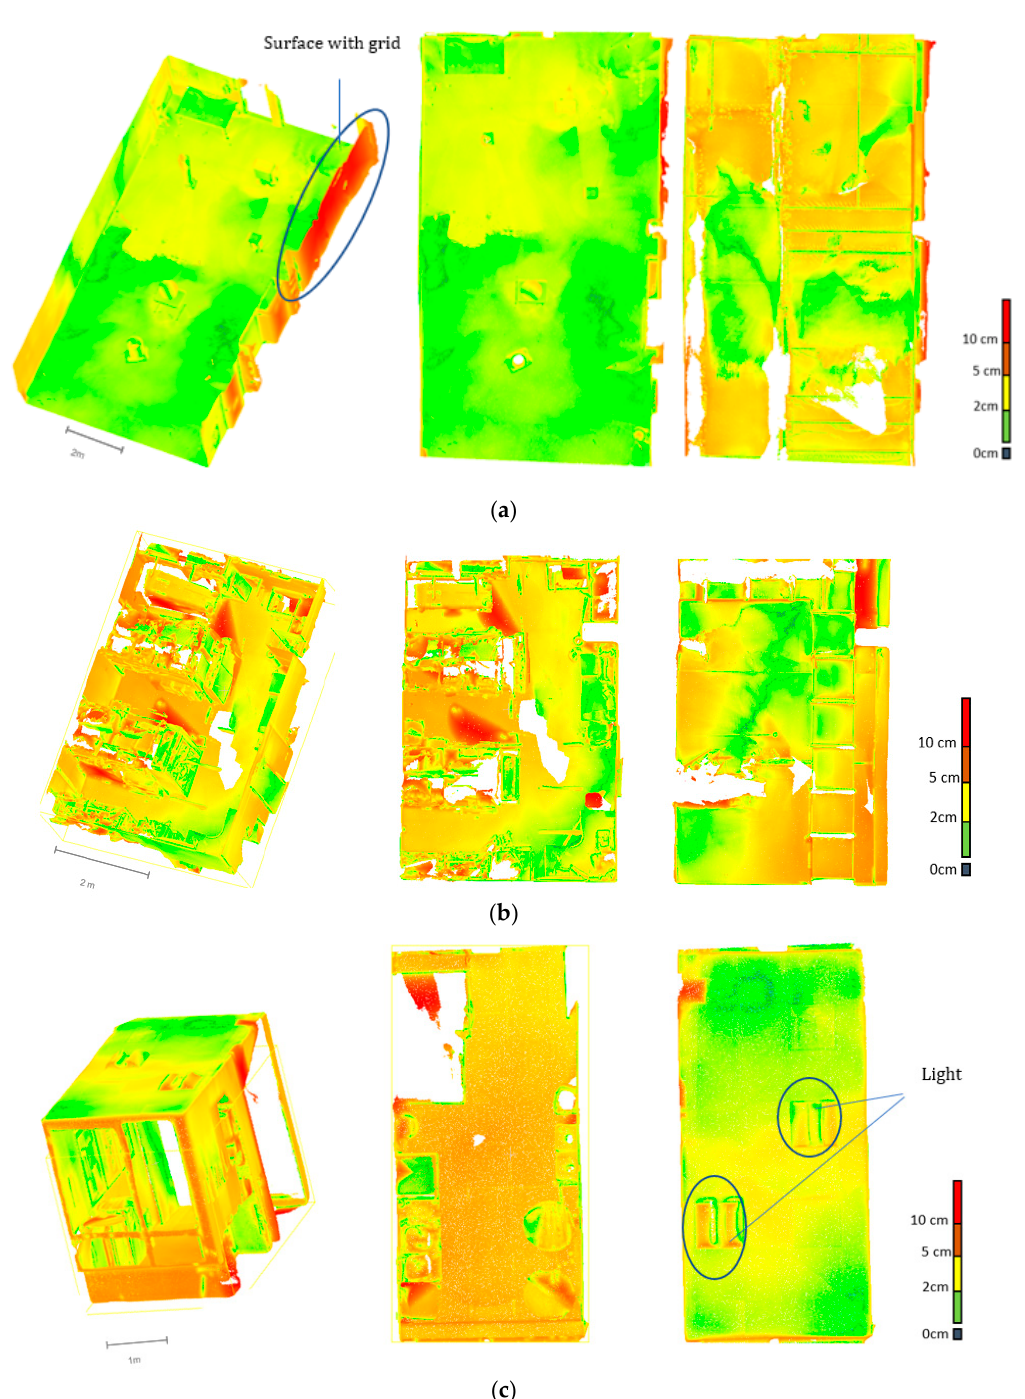
Figure 15. Profile view, ground plane, and ceiling plane showing the deviation map of the LiDAR point cloud from the FARO reference cloud: ( a ) Parking; ( b ) Warehouse; ( c ) local. Colour green is with a deviation of 0–2 cm, yellow with a deviation of 2–5 cm, orange with a deviation of 5–10 cm, and red with a deviation greater than 10 cm. Environments with areas such as cluttered technical rooms, rooms with glass or semi-transparent materials, rooms with intense lighting and reflective surfaces, and outdoor open space should be